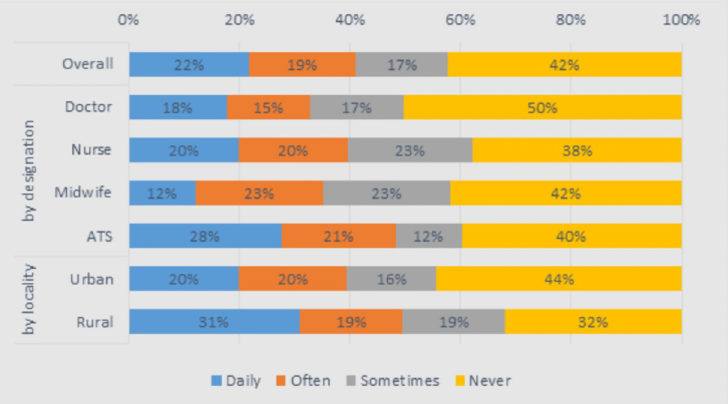
Fig 3. Are you sometimes performing tasks which you were not prepared for in health professional training?